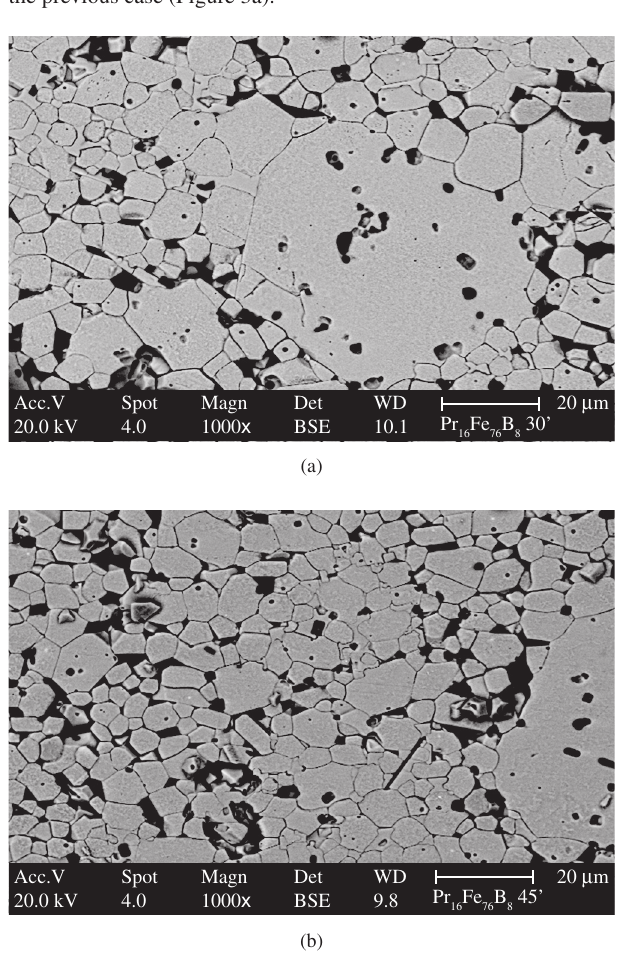
Fe B magnet produced 16 76 8